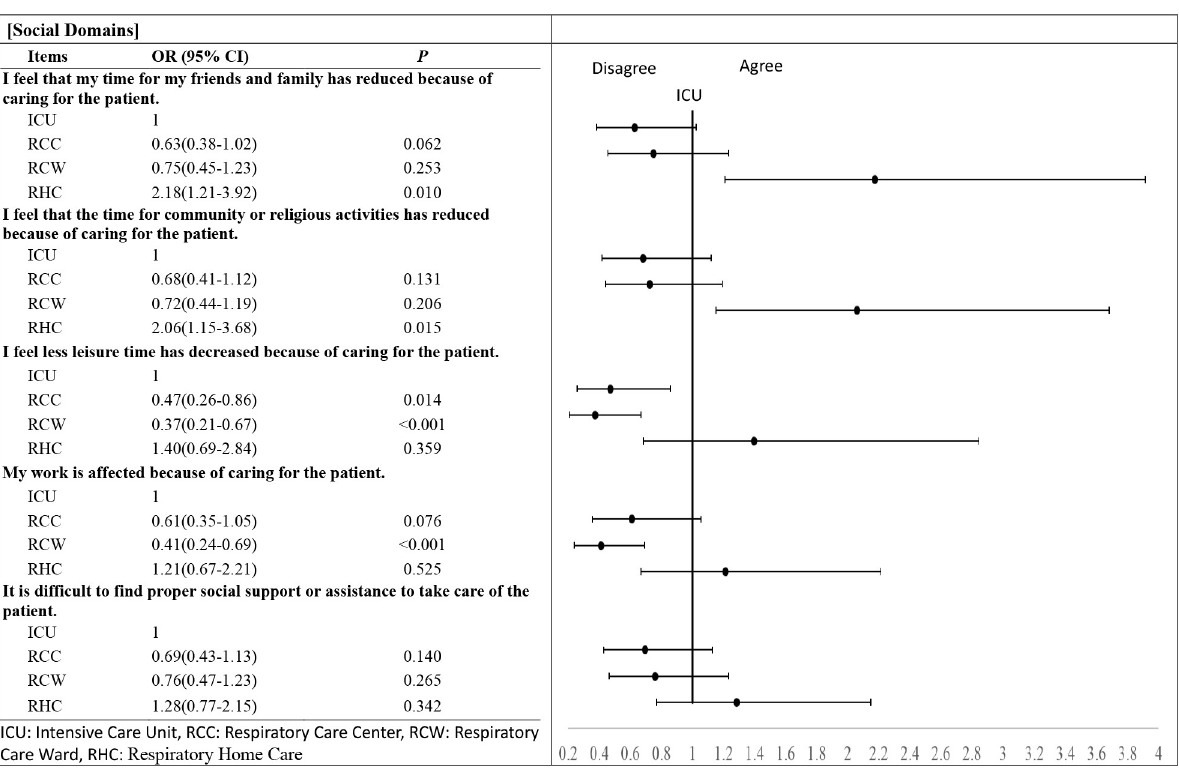
Fig 2. Odds of agreement in the life impact of the caregivers of PMV patients at various stages at social domain.